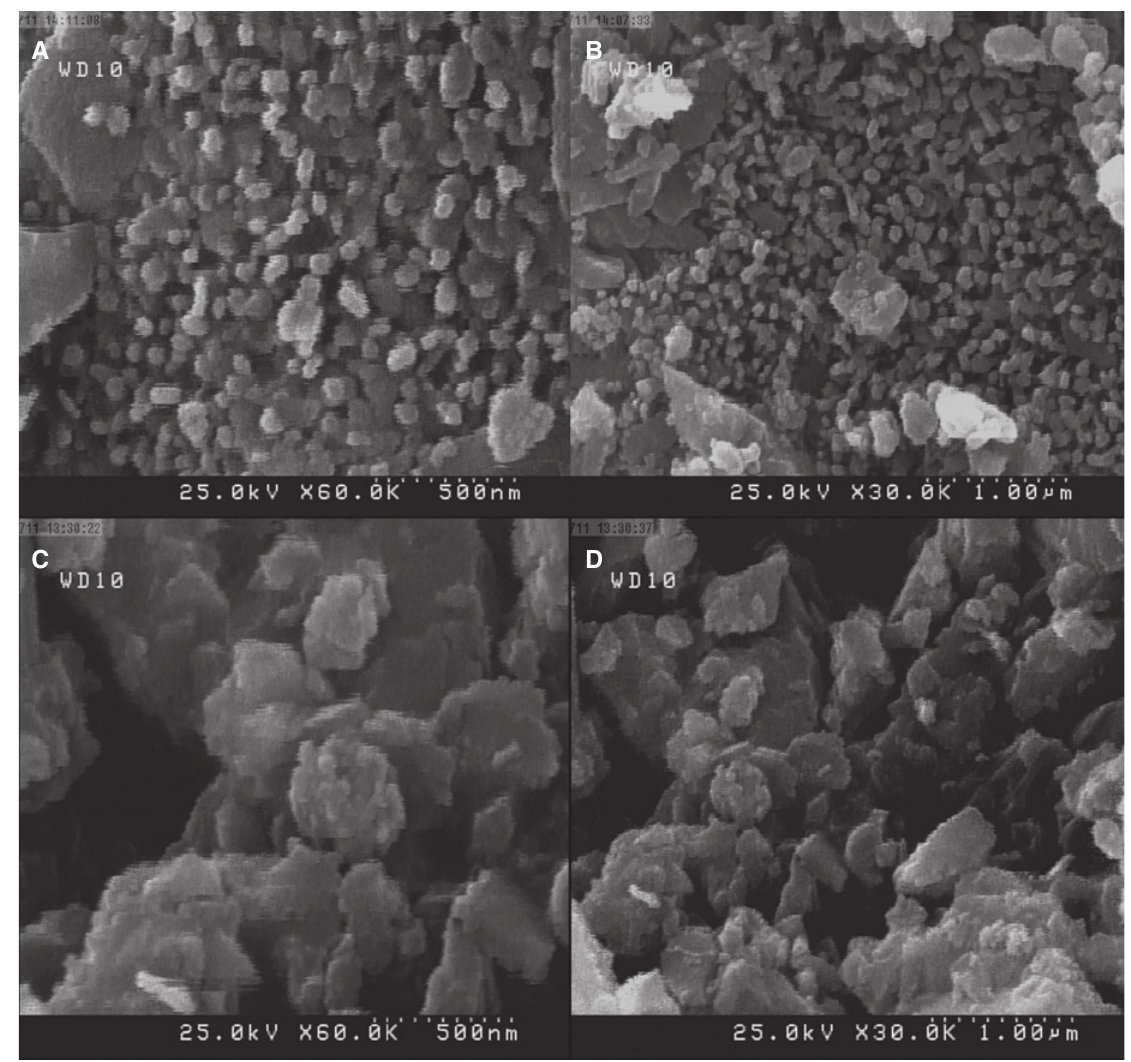
O citric acid-EG (A, B) 500 ° C and (C, D) 700 ° 12 19